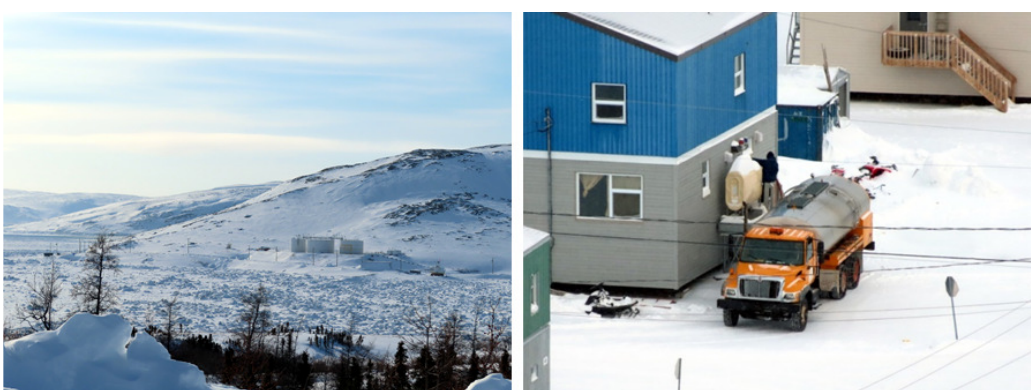
Figure3. Localmanagementof fossilfuels: Community tanksin Kangiqsualujjuaq(left)and a Kangiqsualujjuamiutemployee filling a residential tank with fuel oil